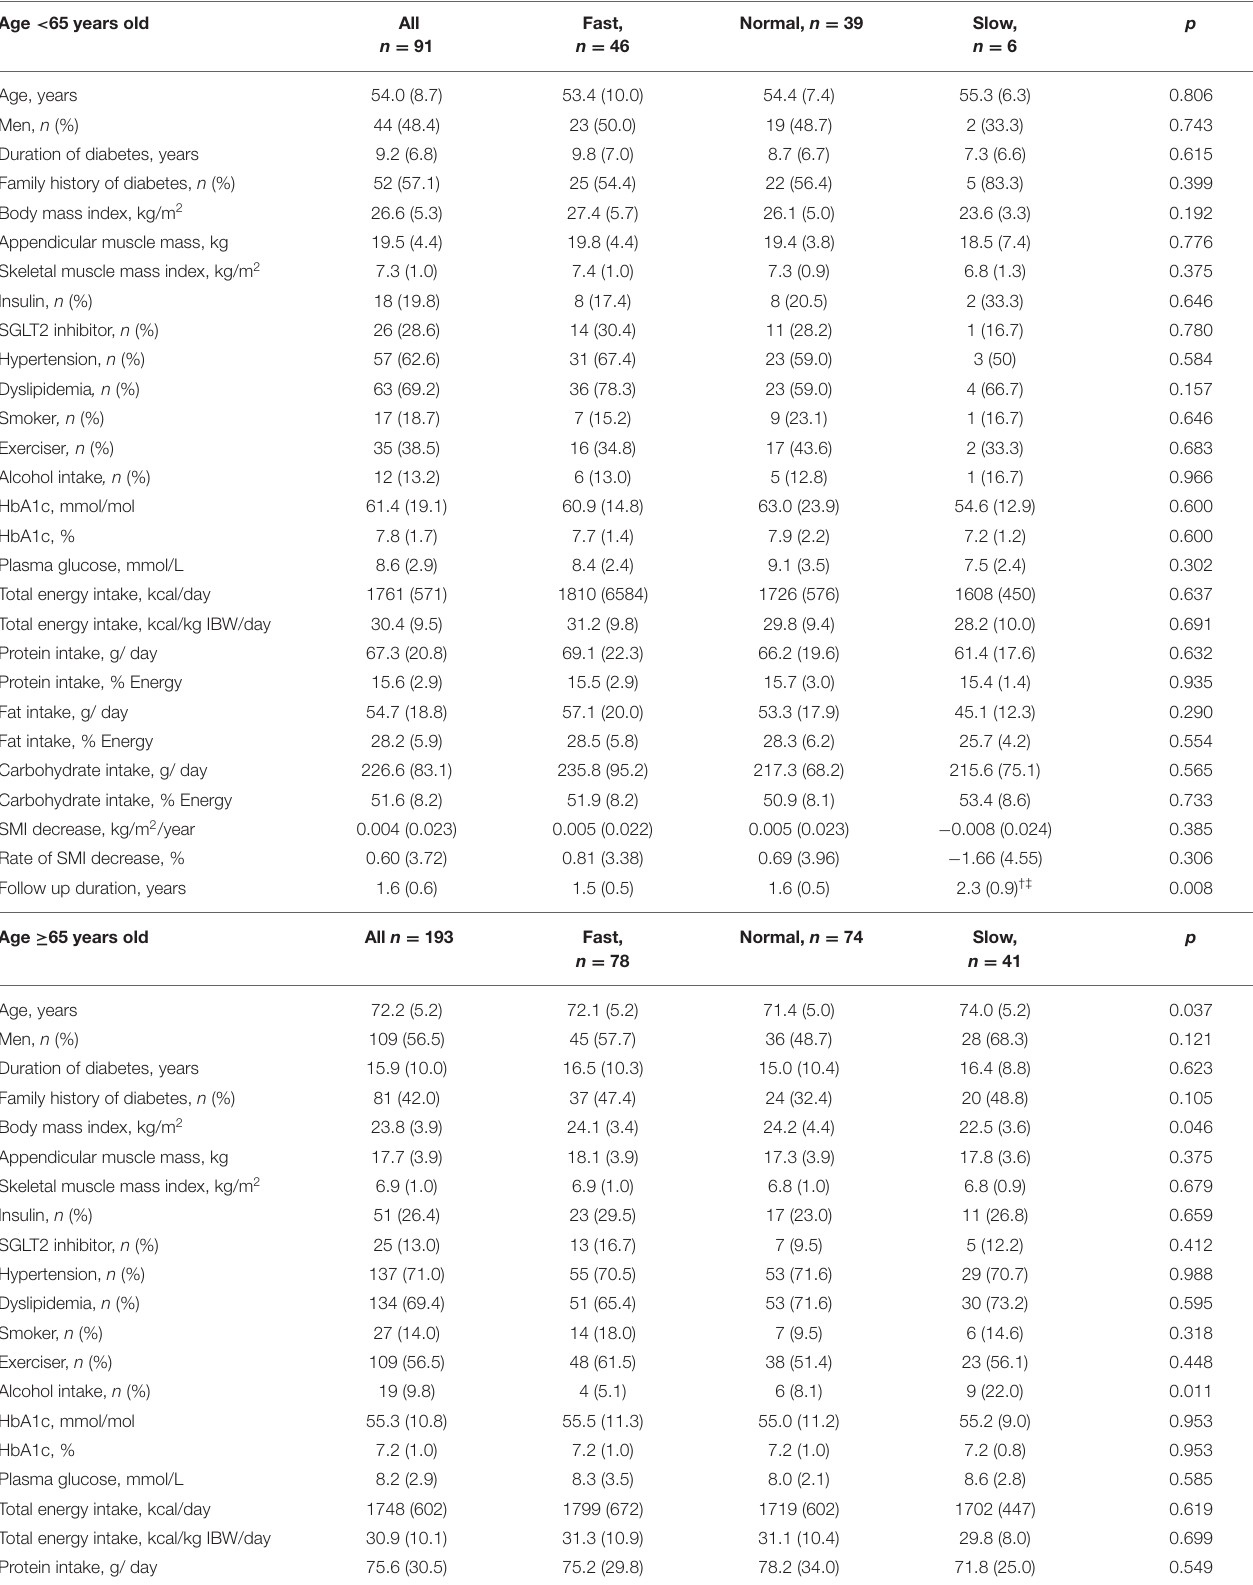
TABLE 1 | Clinical characteristics of study